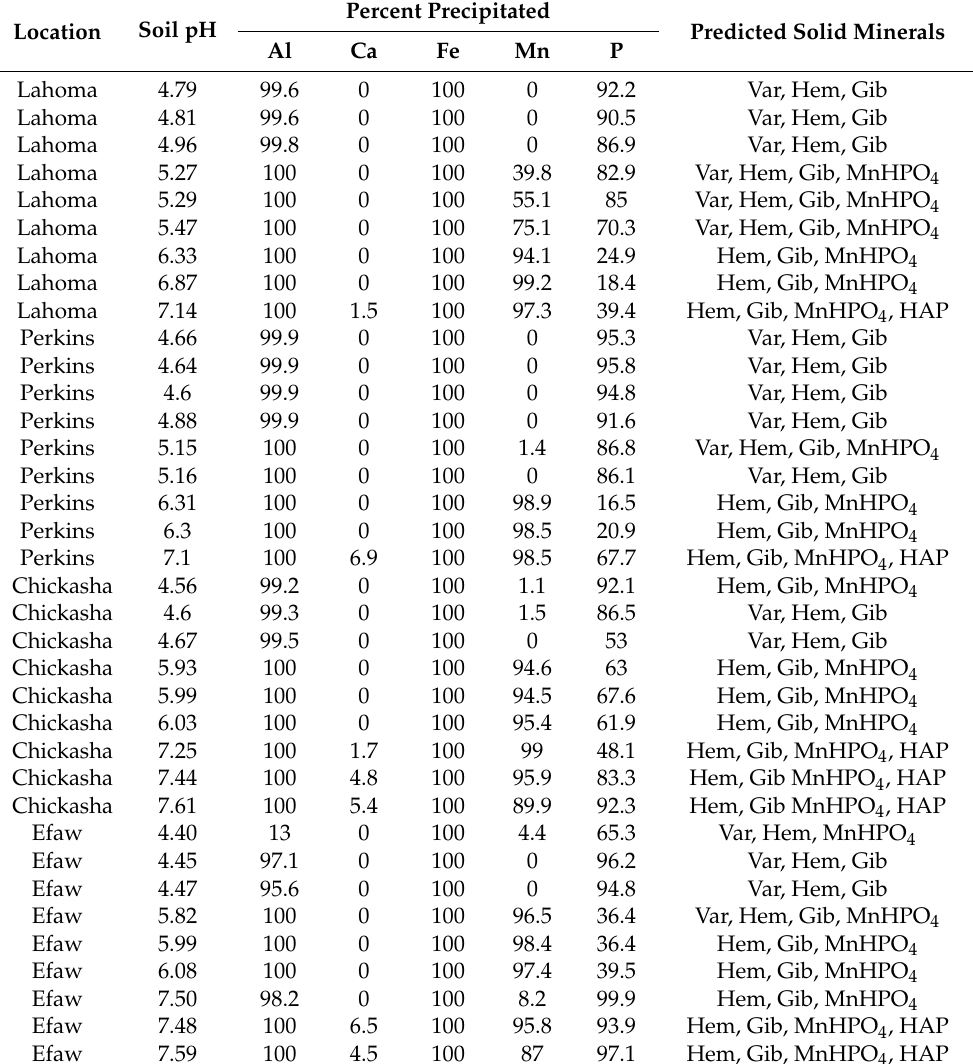
Table 2. Speciation model output of water soluble extracts indicating percent Al, Ca, Fe, Mn, and P precipitated and predicted solid minerals, as a function of soil pH and location. Minerals listed are not meant to explicitly indicate those specific minerals, only the general presence of Al, Mn, and Ca-related P and oxides/hydroxides. Gib = gibbsite, Var = variscite, Hem = hematite, HAP =